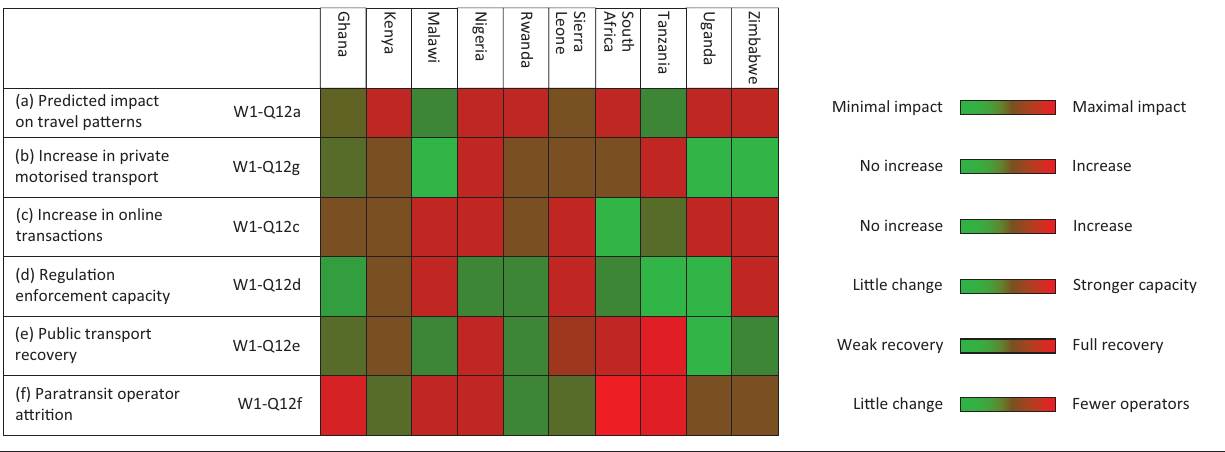
FIGURE 6: Predicted impacts on future travel behaviour and public transport regulation enforcement and recovery, by country (Delphi Wave 1, n =